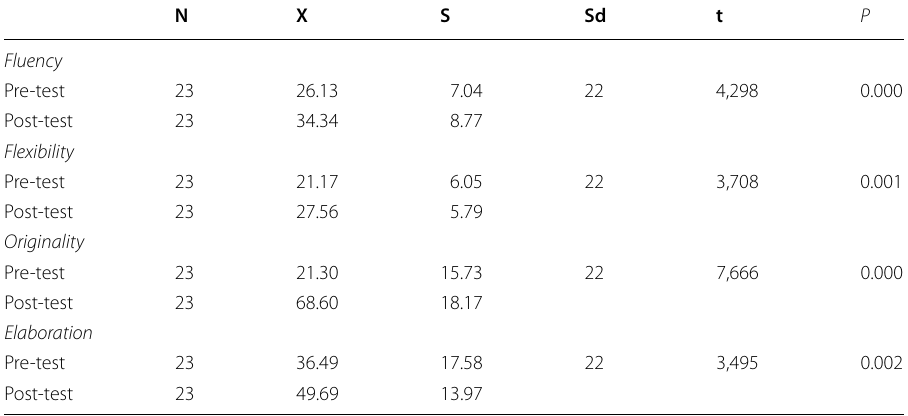
Table 2 T-test analysis results of students’ pre-test post-test scores for TCTT scale